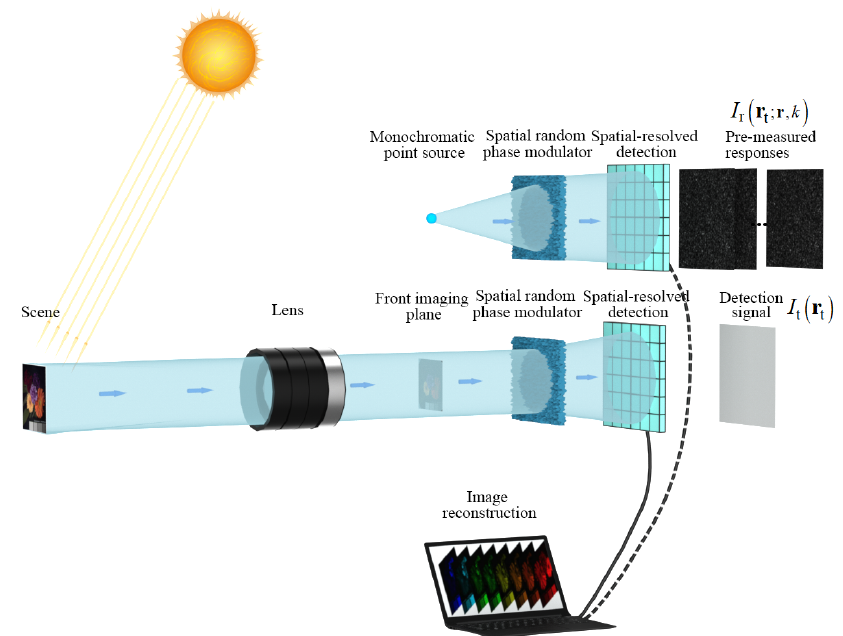
Figure 3. Schematic diagram of the GI spectral camera system [75]. The object illuminated by natural lights is firstly imaged by a front imaging module, then diffracted by a spatial random phase modulator (SRPM), and finally recorded by a detector as a pattern of intensity distribution I t ( r t ) . By the spatial–dimensional second-order correlation between this intensity distribution and the pre-measured impulse response I r ( r t ; r , k ) corresponding to a monochromatic point source δ ( r , k ) where k = 1/ λ , the object’s spatial–spectral information can be